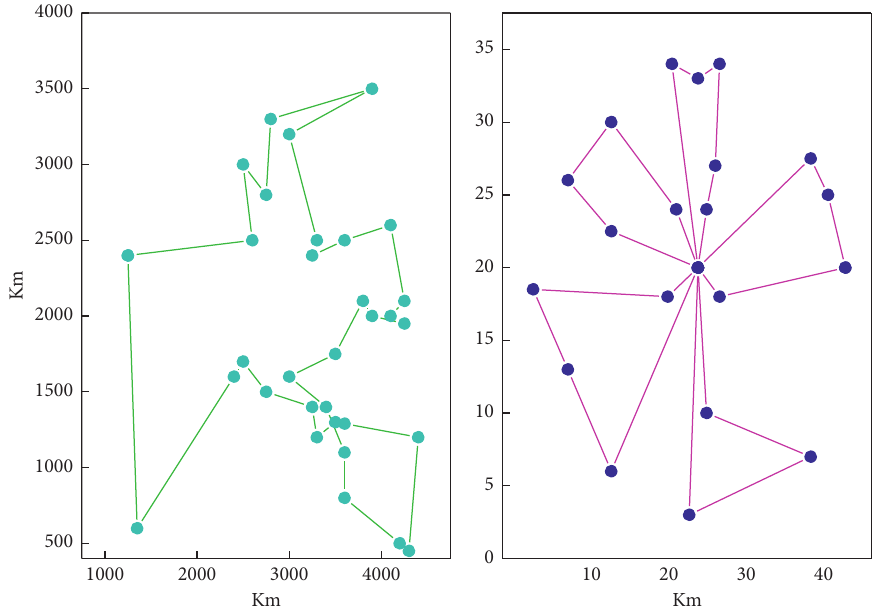
Figure 10: Route arrangement under different delivery and delivery